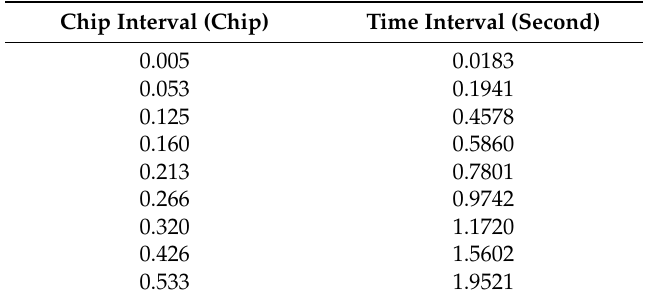
Figure 5. Replica code phase histories for various CI settings. The blue lines indicate the calculated replica code phase values of the original calculation. The red lines indicate the calculated replica code phase with respect to the CI. Table 2. Time interval calculation according to CI.